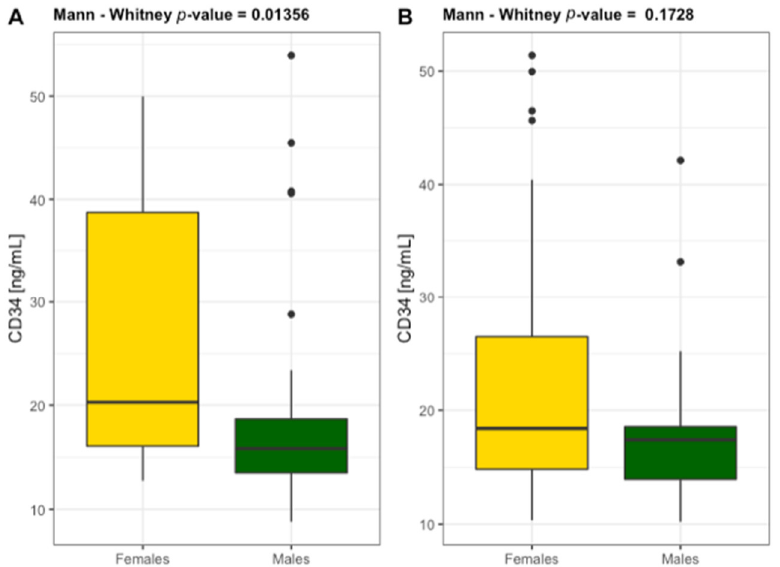
Figure 3. Relationship between ankle-brachial index (ABI) and neopterin (NPT) in patients with peripheral artery disease ( n = 59).